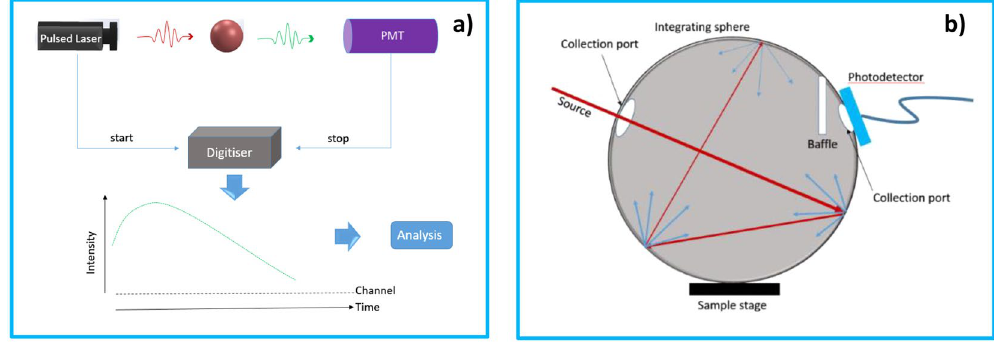
Figure 1. ( a ) Schematic diagram for TCSPC setup. ( b ) Schematic diagram of the integrating sphere setup to measure the quantum yield